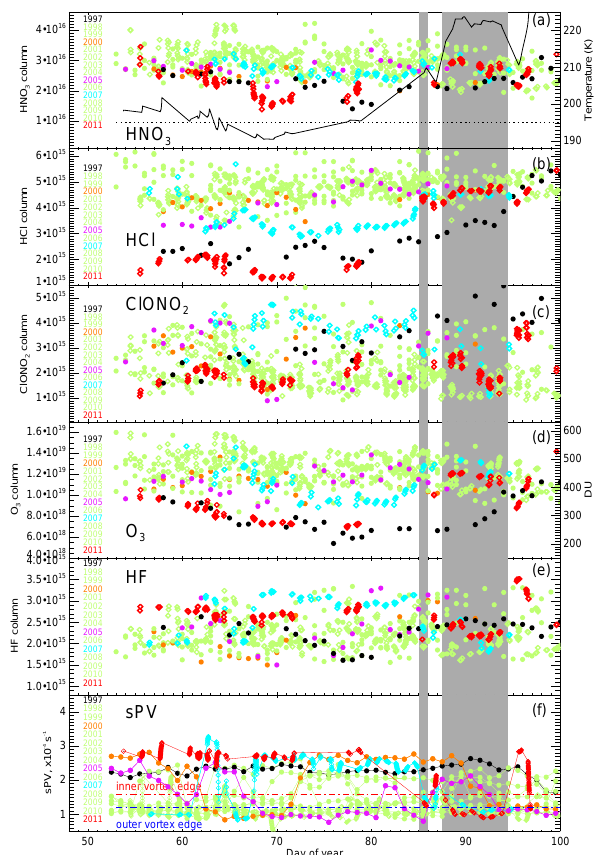
Fig. 5. From (a) to (e) , spring time series of HNO 3 , HCl, ClONO 2 , ozone, and HF total columns from 1997 to 2011, respectively. Filled circles represent DA8 measurements and open diamonds represent 125HR measurements. The colors correspond to different years as shown in the legend. For ozone, panel (d) , the left y-axis gives the column amounts in moleccm − 2 , while the right y-axis gives the column amounts in Dobson units (DU). Panel (a) also shows the evolution of the temperature at 21km along the 125HR line-of-sight for the measurements at Eureka (black solid line) and the threshold temperature value for the formation of type I PSCs (black dotted line). Panel (f) shows the evolution of sPV at 21km above Eureka (as described in the text), for all years as shown in the legend. For the years with 125HR data, sPV is only shown for days when mea- surements were made. The red and blue dot-dash lines show the inner (red) and the outer (blue) vortex edge, respectively. The gray shading highlights the days when the instrument sampled air masses on the edge or outside the